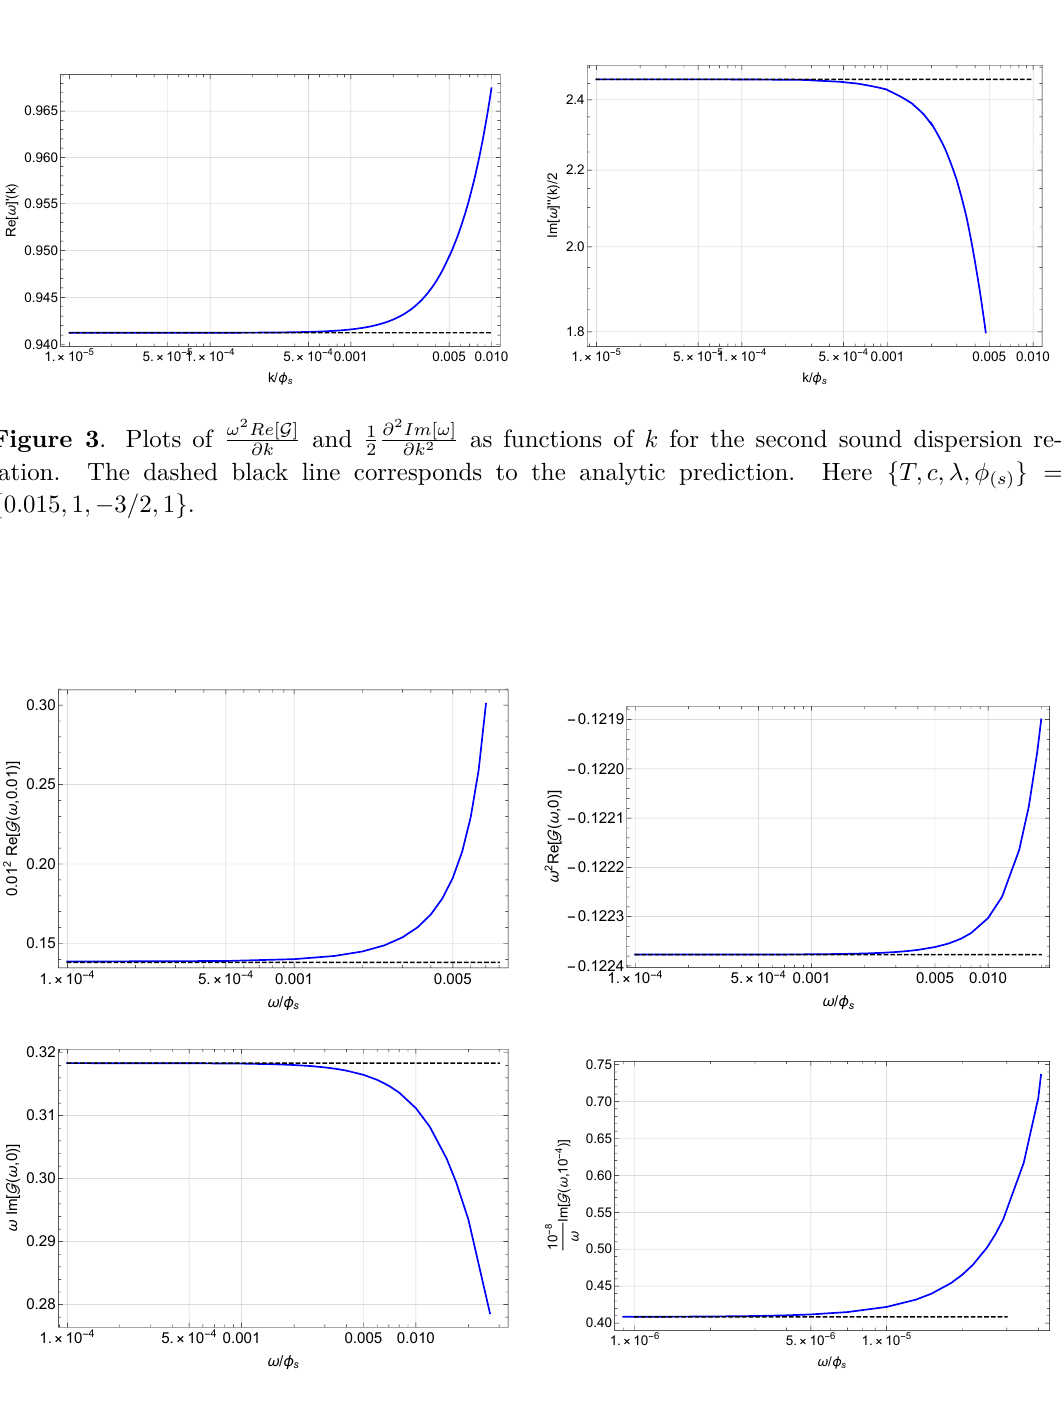
Figure 4 . Plots of G as a function of ω for k = 0 and k = finite. The dashed black lines corresponds to χ QQ (top, left), − χ JJ (top, right), σ d (bottom, left) and Ξ (bottom, right). Here { T, c, λ, φ } = { 0 . 015 , 1 , − 3 / 2 , 1 } ( s )